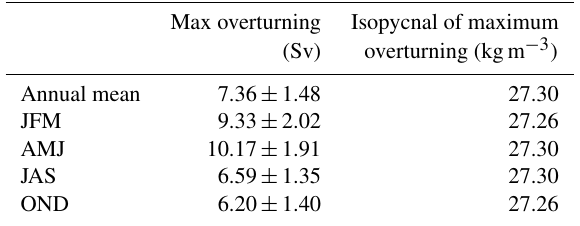
Table 2. Overturning strength and its location in density space by season. Max overturning Isopycnal of maximum